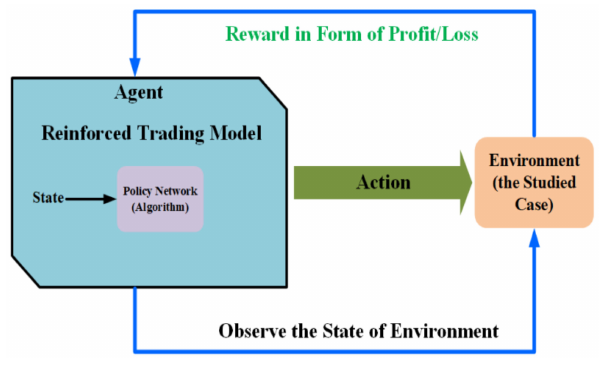
Figure 4. The reinforcement learning